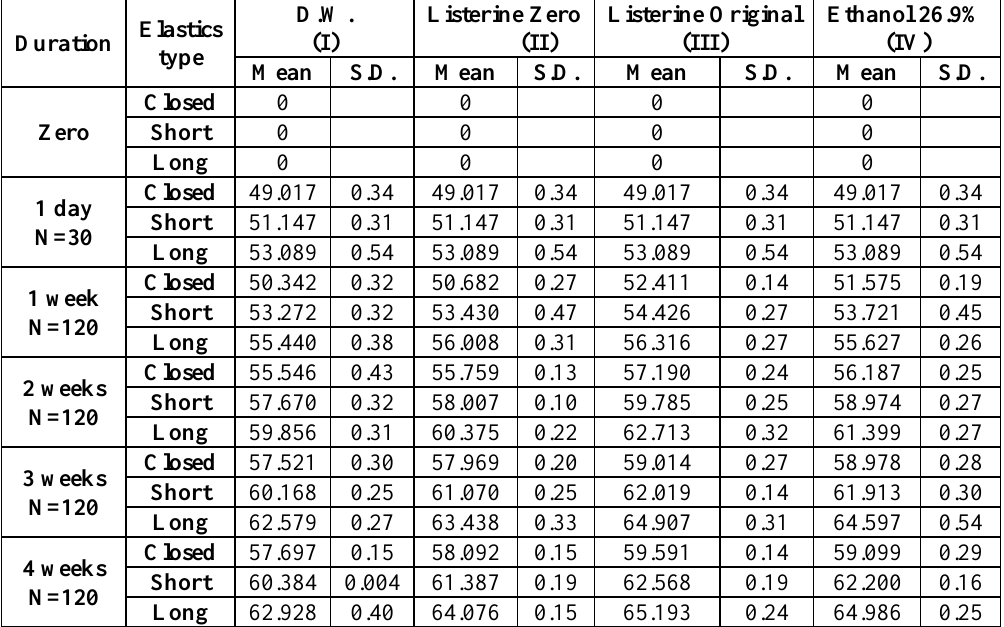
Table 2: Means and standard deviations of the percentage of force decay of different types